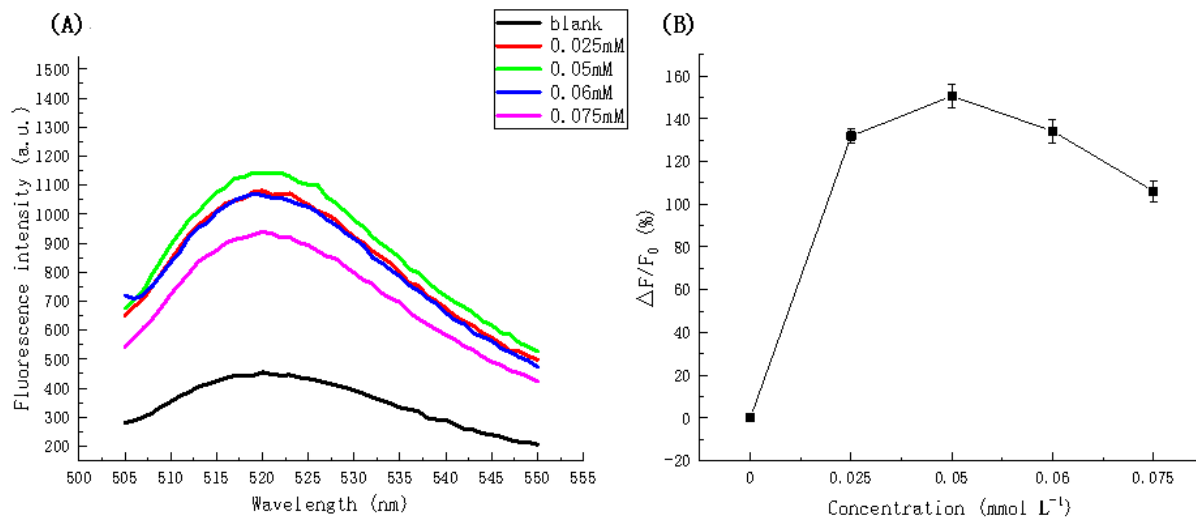
Figure 6. ( A ) Fluorescence spectra in the presence of different concentrations of dNTPs. ( B ) Fluorescence intensity ratio ( △ F / F 0 ) at an emission wavelength of 520nm in the presence of different concentrations of dNTPs.